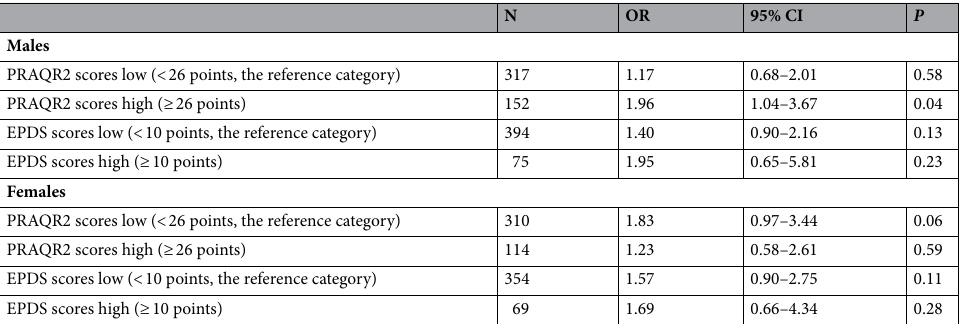
Table 4. The association of IL6 (rs1800795) a variant genotype and the risk for RRIs in groups stratified according to prenatal maternal psychological distress exposure, assessed separately for males and females. Odds ratio (OR) for recurrent respiratory infections, Interleukin 6 ( IL6 ). a Additive Model: major/major allele = 0, minor/major allele = 1 ja minor/minor allele =